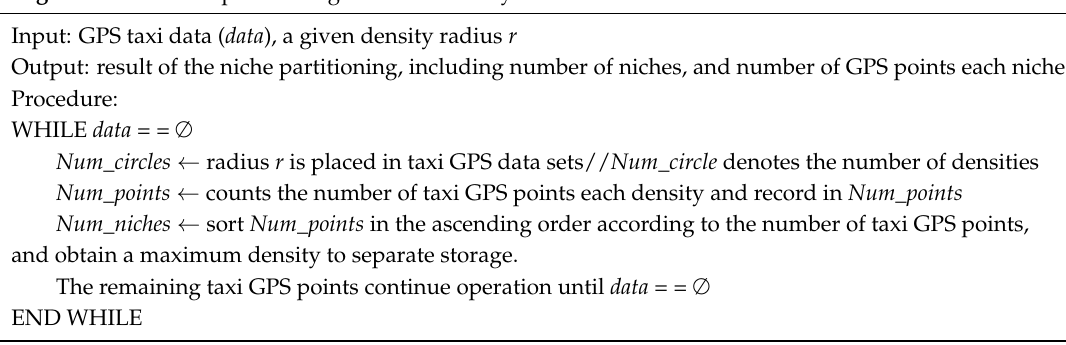
Algorithm 2. Niches partitioning based on